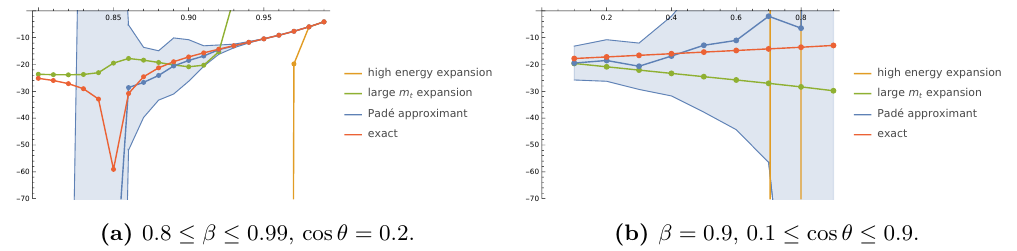
Figure 4. Comparison of the interference for the LLLL helicity amplitude.